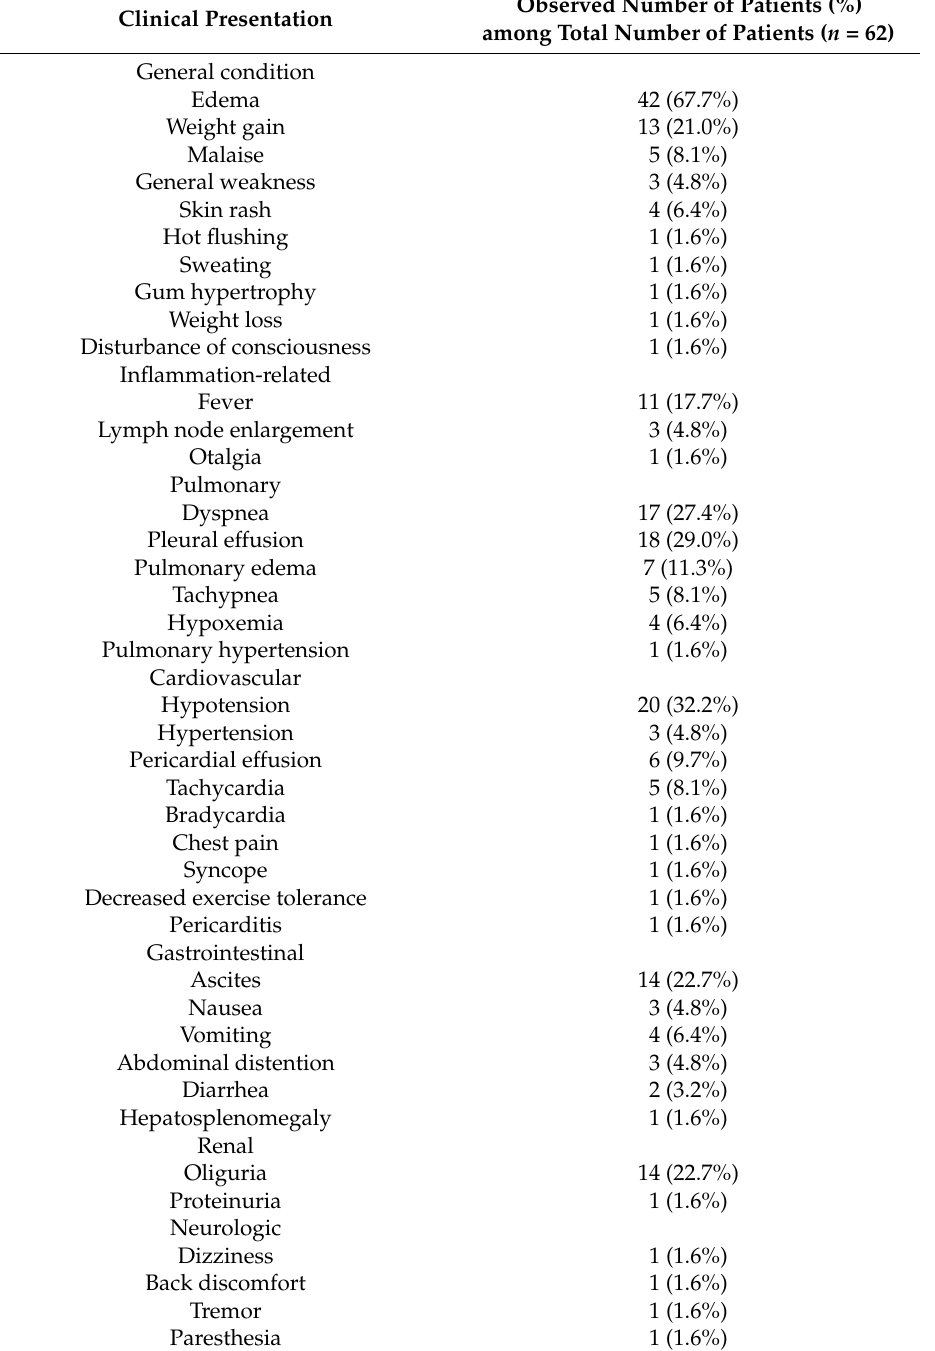
Table 3. Clinical presentation of cancer patients with systemic capillary leak